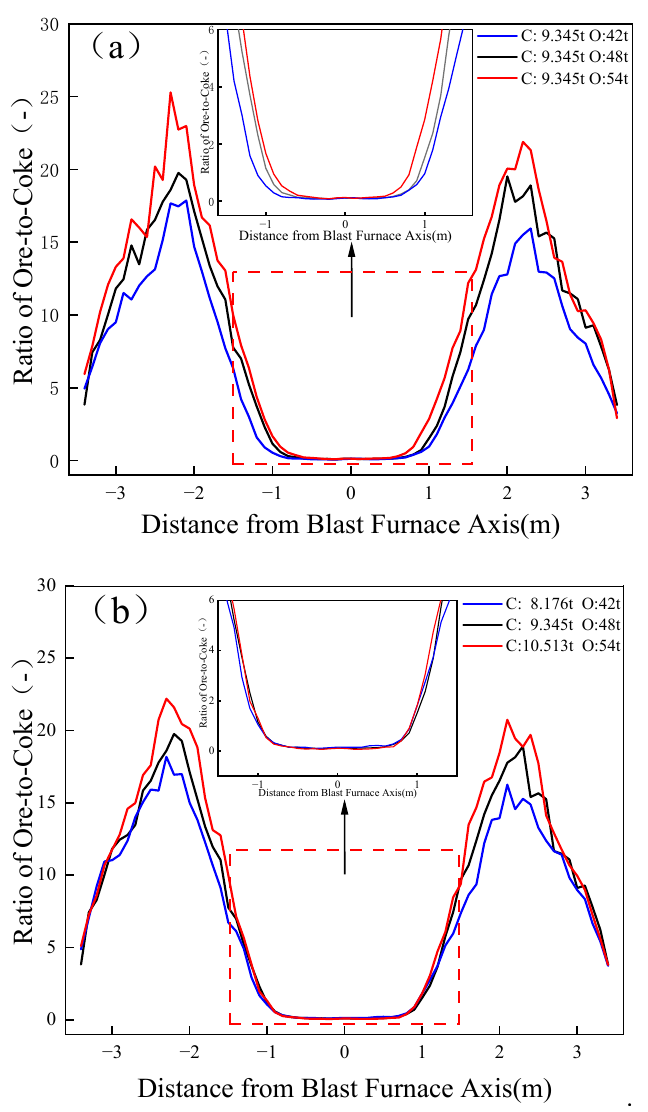
Figure 15. Effect of the charge batch weight on the ore–coke ratio within the ore-free zone: ( a ) change in ore batch weight only; ( b ) change in coke and ore batch weight at the same time.